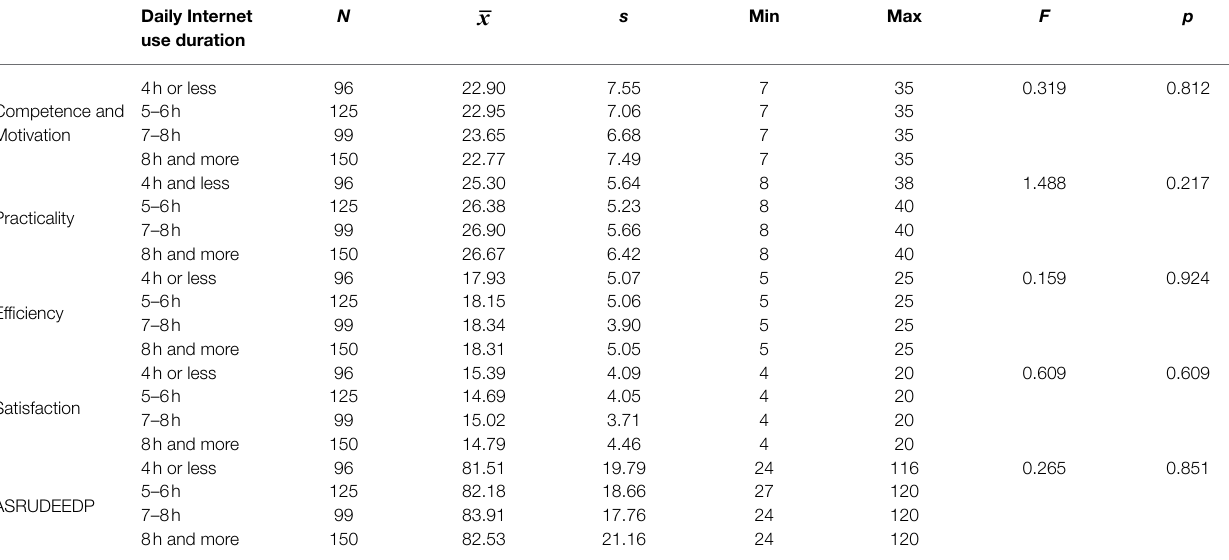
TABLE 4 | Comparison of the students’ scores from ASRUDEEDP according to their daily Internet use durations. Daily Internet N x ̅ s Min use duration